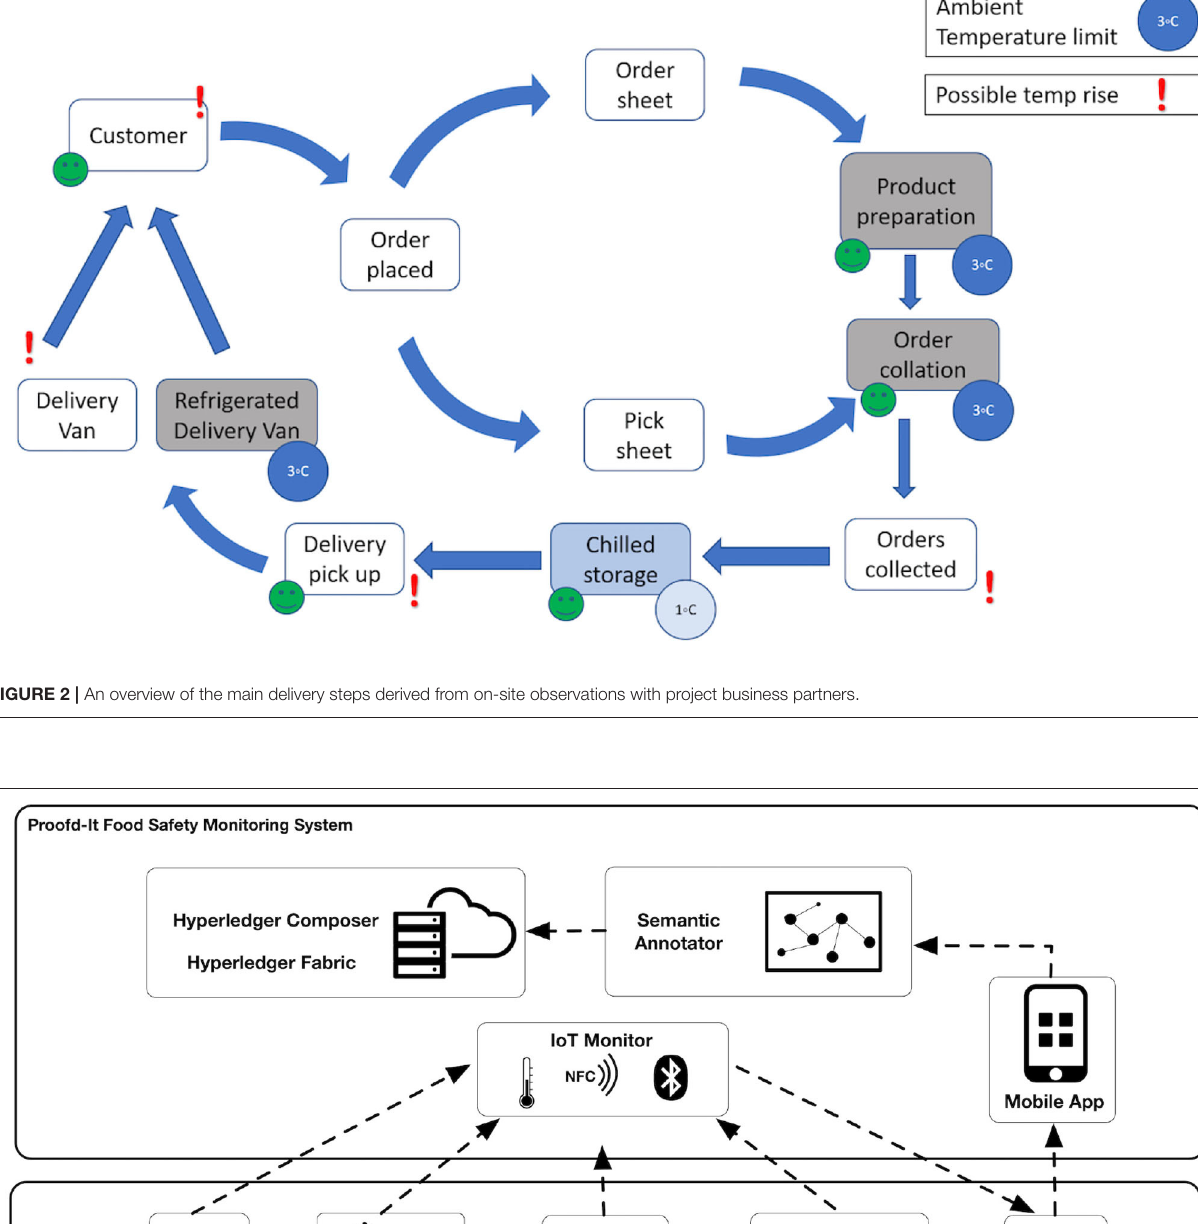
Frontiers in Sustainable Food Systems |